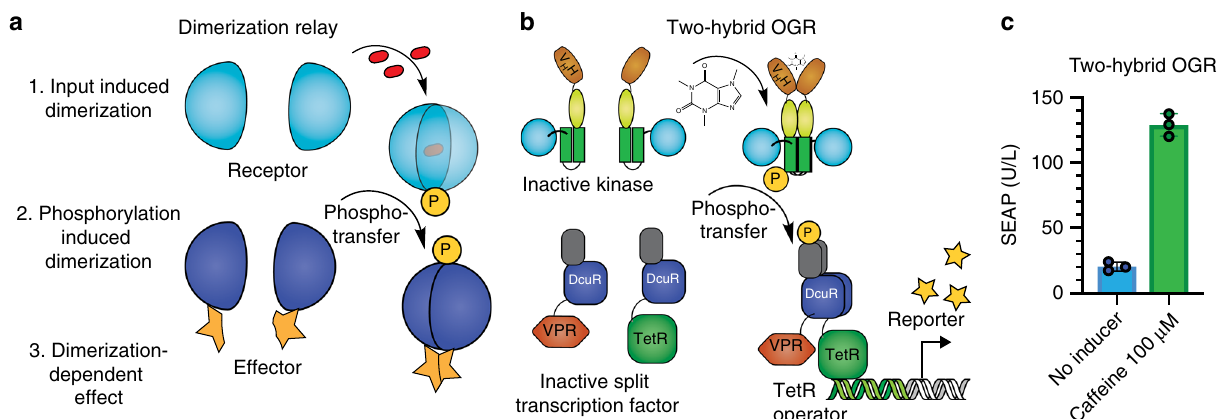
Fig. 4 POST as a dimerization relay system. a Schematic of the proposed basic building block of protein circuits using a phosphoregulated relay system of protein dimerization. This system consists of a dimerization-dependent receptor and a dimerization-dependent effector. b Schematic of POST as a dimerization relay system by a two-hybrid OGR design. The two-hybrid OGR serves as an example of a phosphoregulated effector protein that performs its function upon dimerization. It consists of DcuR fused to TetR, and DcuR fused to the DNA transactivation domain VPR. Phosphoregulation by ORKs controls the dimerization of TetR-DcuR and DcuR-VPR and only dimerized TetR-DcuR/DcuR-VPR will induce reporter gene expression from a TetR operator. c Reporter gene expression from a TetR operator in response to caffeine in the two-hybrid OGR design. The bar chart shows the mean ± s.d. of n = 3 biologically independent samples overlaid with a scatter dot plot of the original data points, measured at 24 h after induction, and the results are representative of three independent experiments. Source data are provided as a Source Data fi